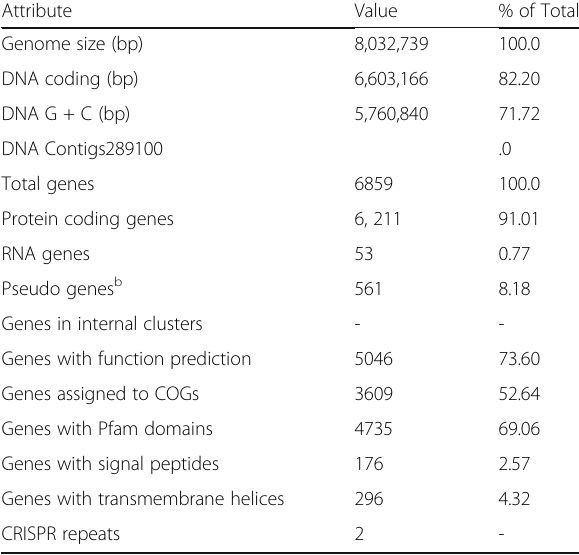
Table 3 Genome statistics